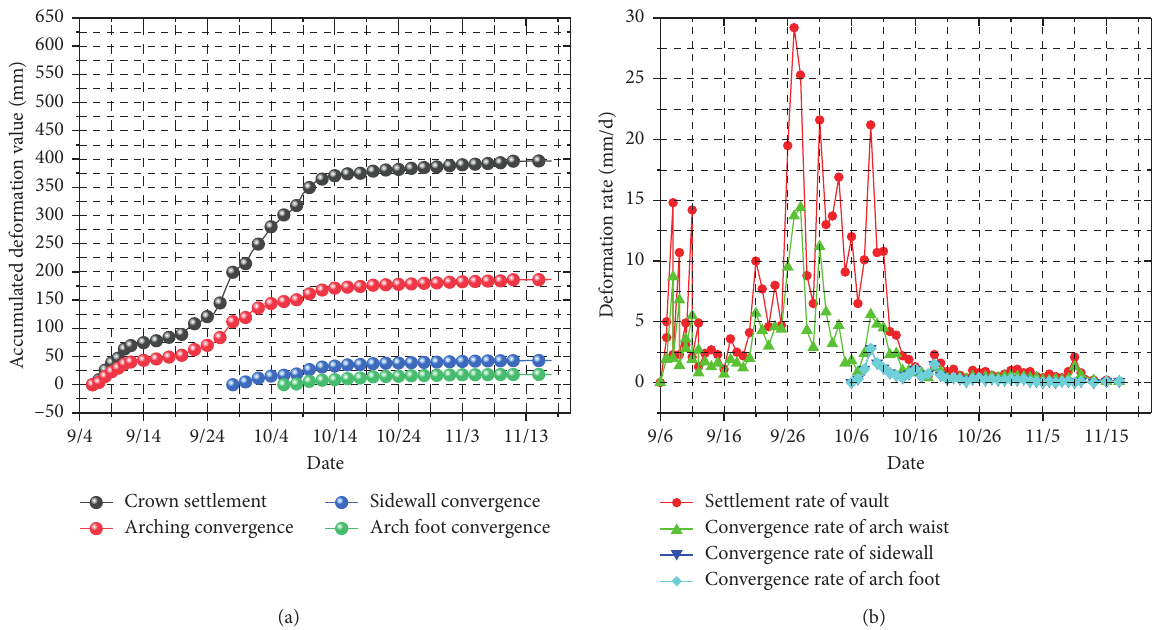
Figure 2: A time-dependent displacement curve of rock mass of section YK11 +465 in Qiguding tunnel: (a) cumulative value of de- formation; (b) rate of deformation.